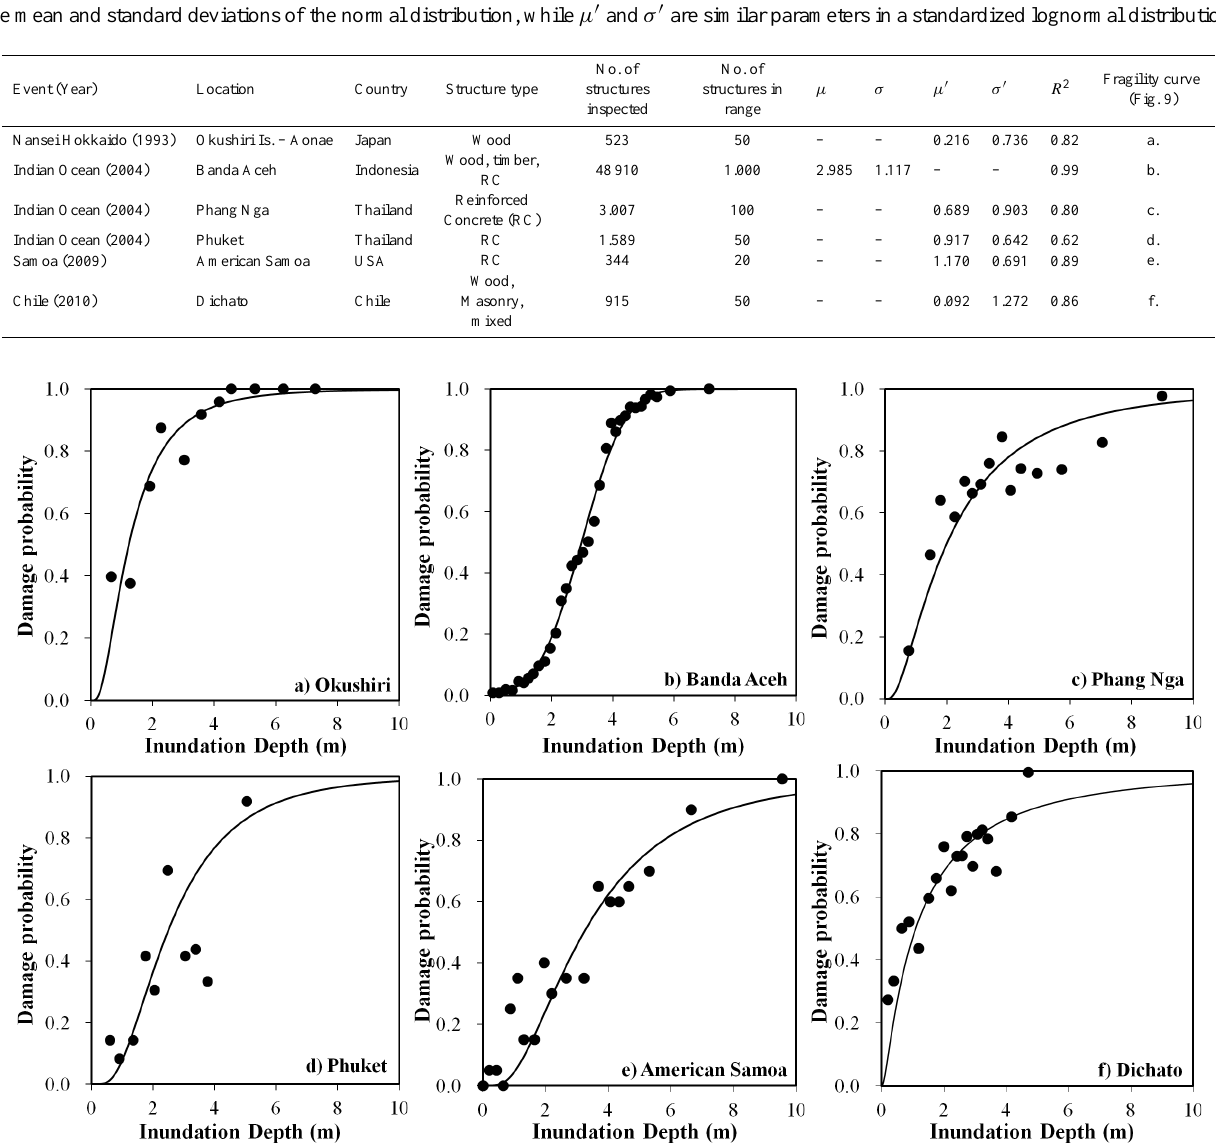
Fig. 9. Tsunami fragility curves for structural destruction probability previously developed for other locations on the globe. (a) Japan; (b) Indonesia; (c) , (d) Thailand; (e) American Samoa – USA; (f) Chile.